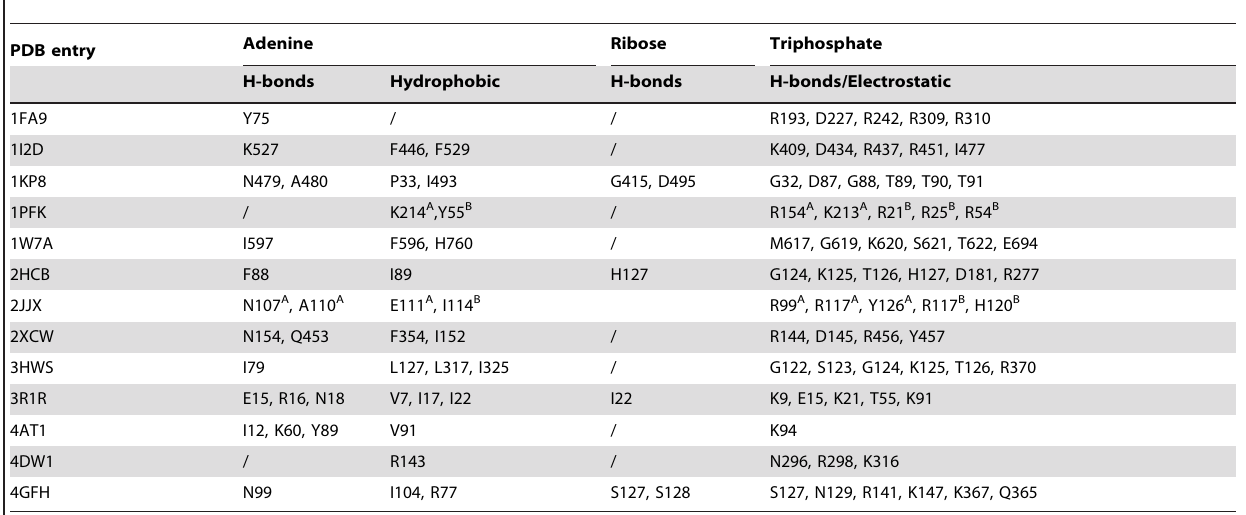
Table 2. Interactions between adenine, ribose, and triphosphate parts of ATP and allosteric proteins.